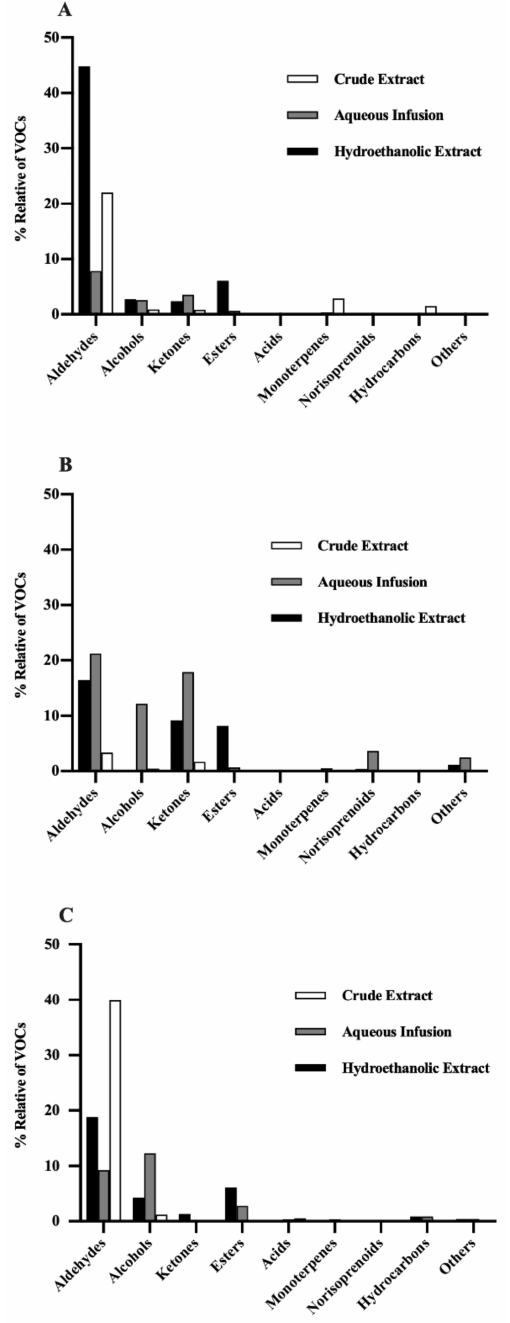
Figure 3. Percentage of the total volatile organic compounds (VOCs) represented by the different classes of compounds in the hydroethanolic extract, aqueous infusion, and crude extract of Prunus avium L. ( A ) stems, ( B ) leaves, and ( C ) flowers from the Saco